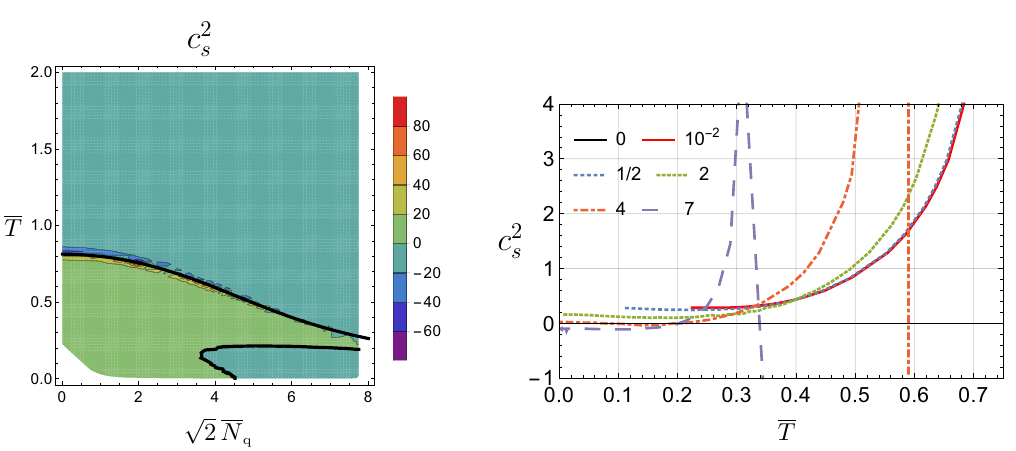
Figure 17 . (Left) Contour plot of the speed of sound squared. The thick, black, continuous curve changes sign. (Right) Plots of the speed of sound as a function of indicates the locus where c 2 s . The speed of sound diverges temperature for several fixed values of the charge density √ 2 N q towards positive (negative) infinity as the upper black curve is approached from below (above). This is why the scale of the contour plot has such a large